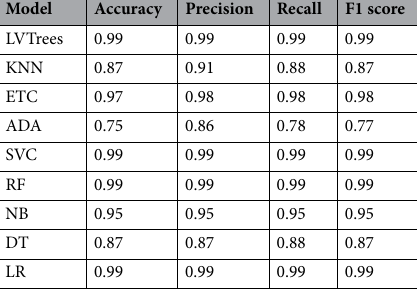
Table 12. Performance of models applying ADASYN